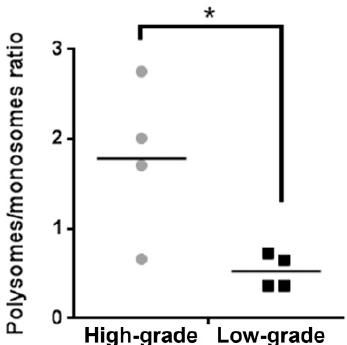
Figure 2. Fragments with high ‐ grade histology have increased translation rates. Translation rates were estimated from the polysome profiles. The area under the polysome and 80S peaks was measured in Image J and the polysome/80S ratio was calculated. Fragments 1 to 4 were considered high ‐ grade and fragments 5 to 8 were considered low ‐ grade. *Student’s T test p = 0.02.